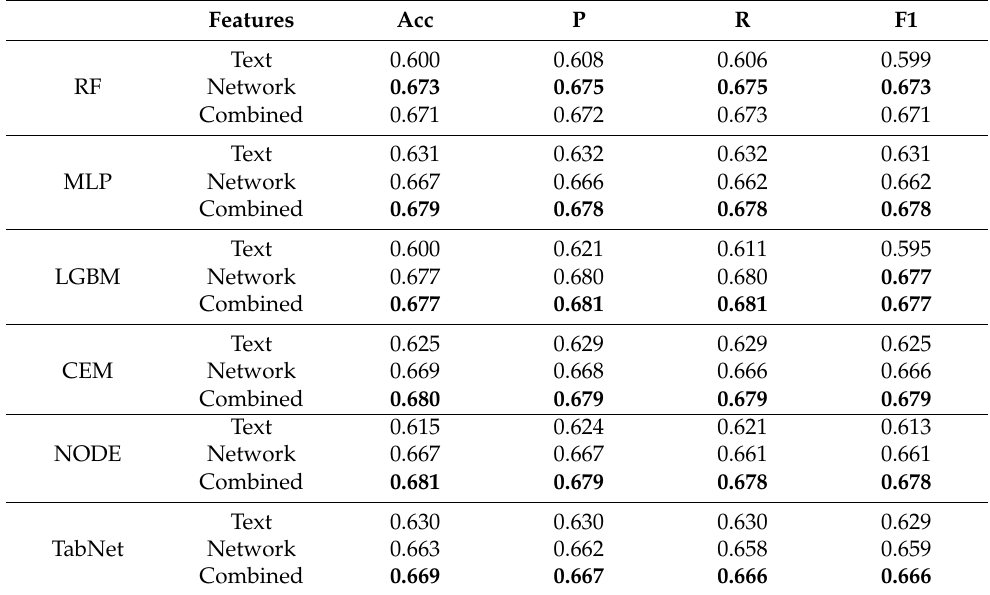
Table 1. Comparison of results for six trained models in combination with three different set of